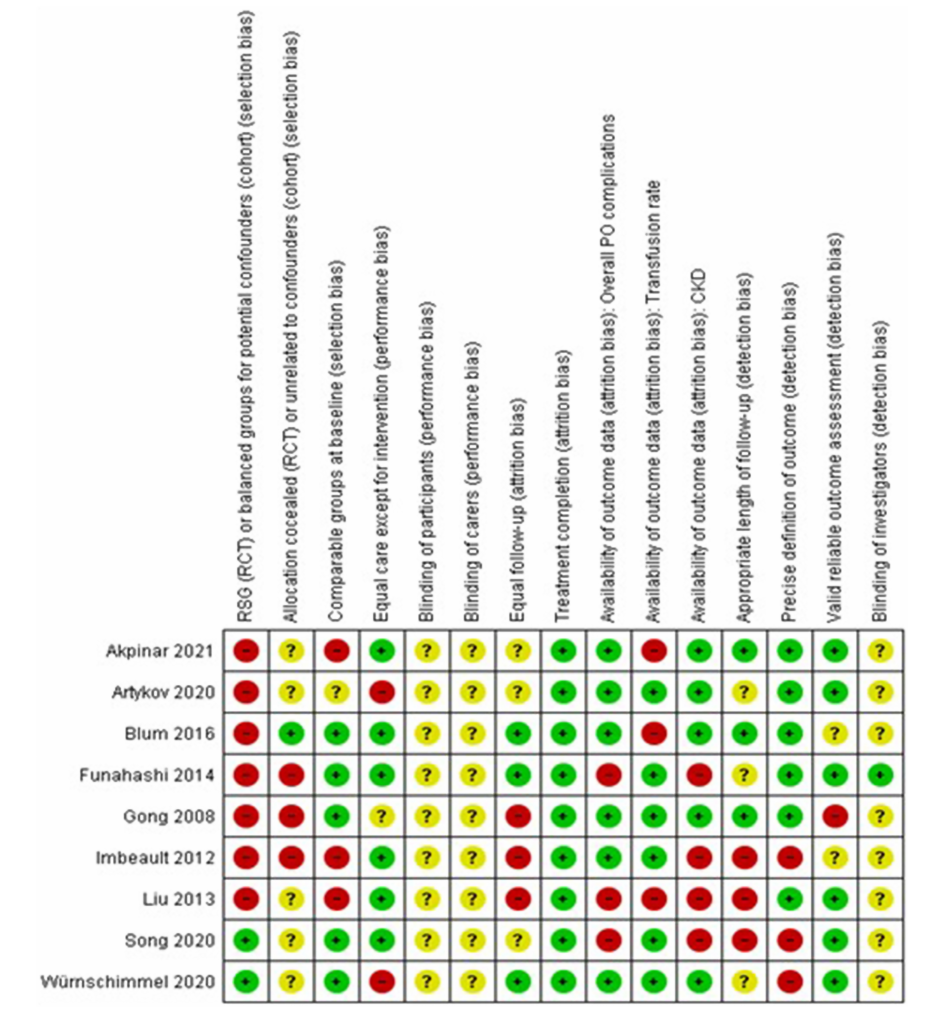
Figure 2. Risk of bias summary as assessed for each study. RCT, randomized controlled trial; RSG, random sequence